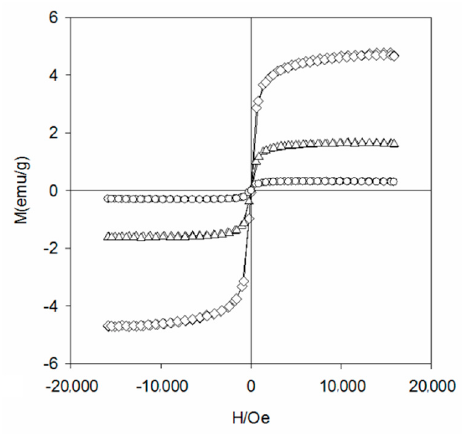
Figure 4. The magnetization curve of WBC10( ◊ ), WBC11( Δ ) and WBC12( ○ ).